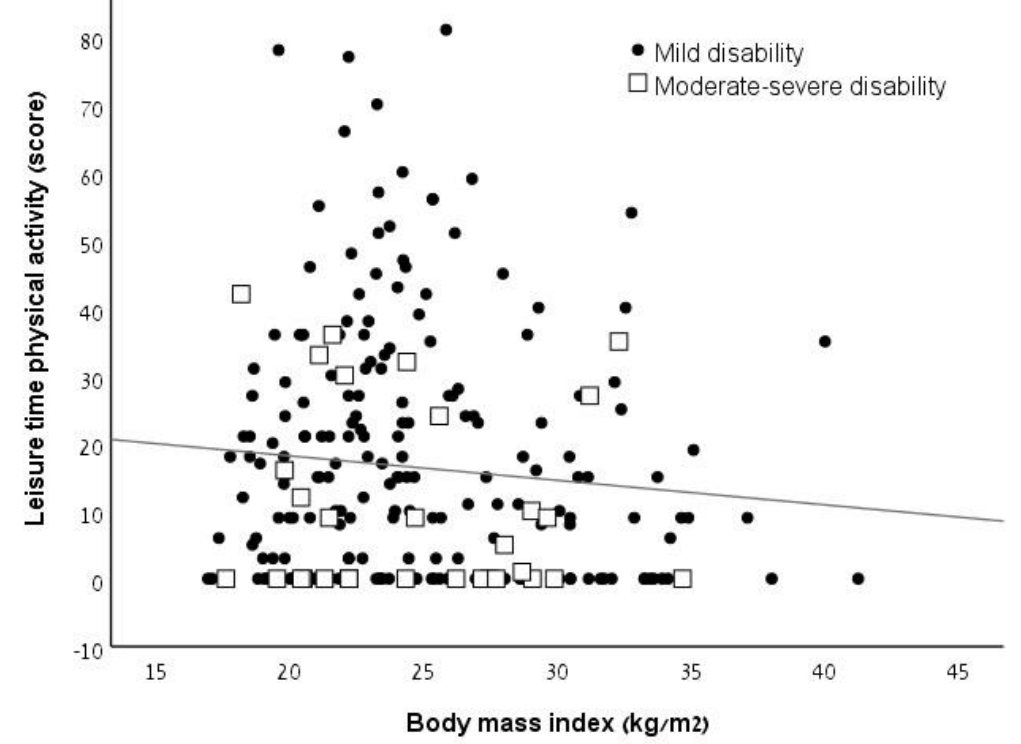
Figure 1. Relationship between obesity and leisure-time physical activity according to disability subgroups.